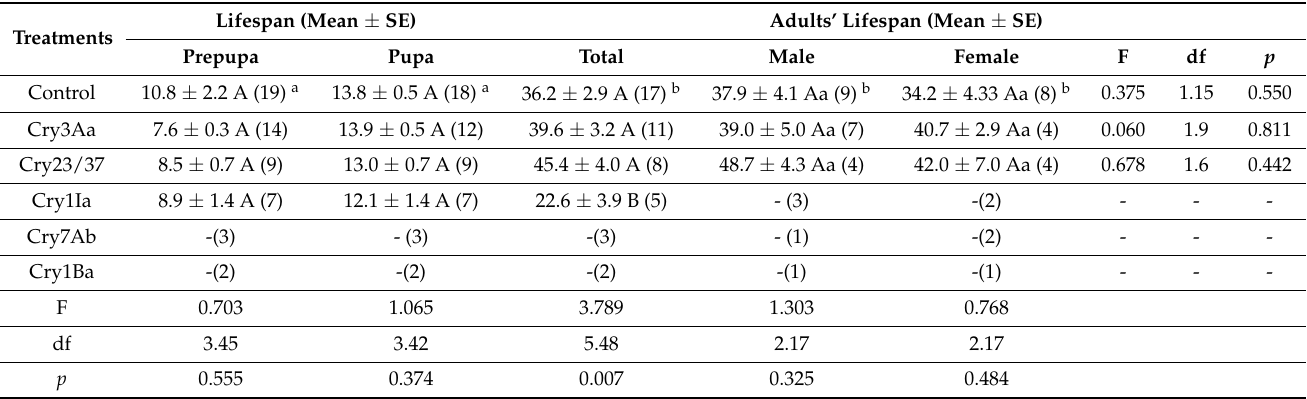
Table 1. Developmental time of pupal stages and adults’ lifespan in days after Cry protein treatments. The number of scored insects is given in